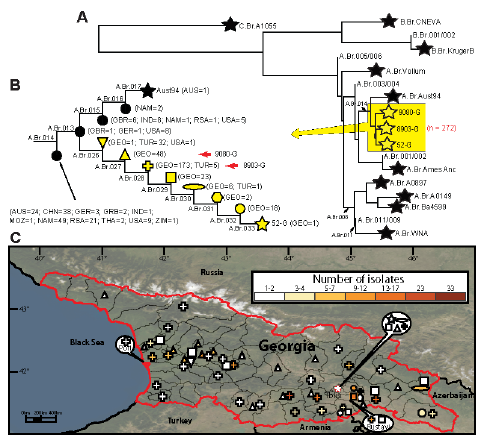
Figure 1. Bacillus anthracis phylogenetics in Georgia. A) Established phylogeny of B. anthracis [2,6–8]. Terminal subgroups representing sequenced strains are shown as stars, and intervening nodes representing collapsed branches appear as circles. The high- lighted yellow box (part of the Aust94 lineage) indicate the phylogenetic location of Georgian strains. Stars within the highlighted yellow area represent the three Georgian strains sequenced for this study. The number of Georgian strains is indicated in red. B) Expansion of the Aust94 group and canSNP subgroups within the Georgian lineage. The number and origin of isolates are shown for each node and stars or red arrows indicate the locations of the sequenced strains. Shapes of nodes correspond to geographic location. (C) Phylogeogra- phy of 272 B. anthracis isolates falling in the Aust94 group are mapped across the country of Georgia at a district level. The heat map legend indicates the number of isolates per subgroup found in a given district.